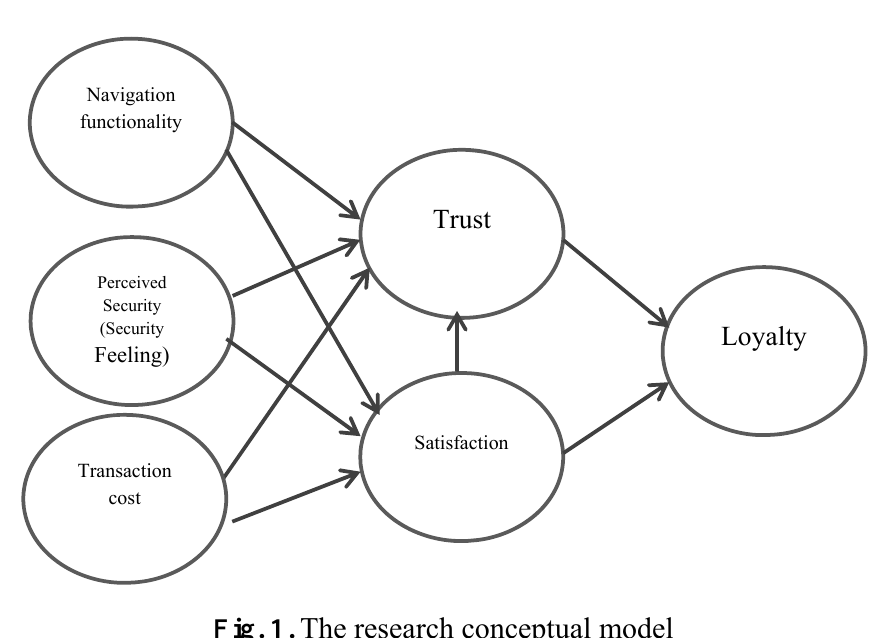
Fig. 1. The research conceptual